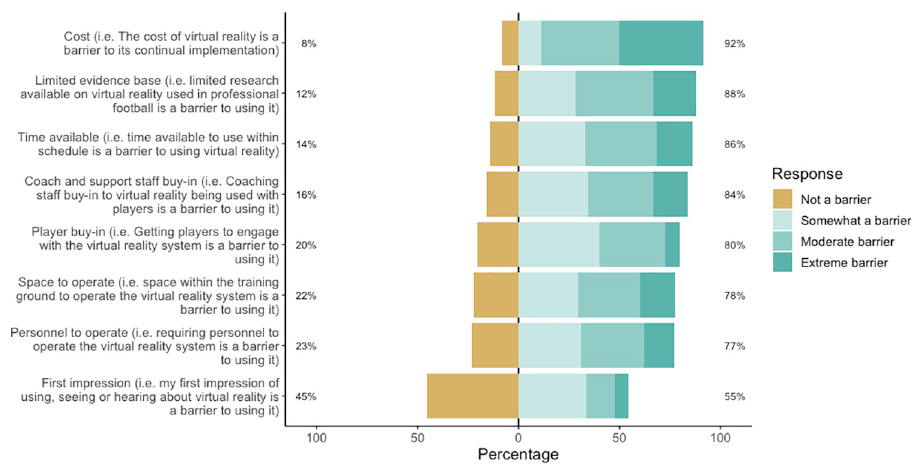
Fig 4. Responses by practitioners to statements regarding facilitating conditions to using VR. Percentages indicate not a barrier and overall barrier, from left to right respectively. For the statement ‘cost’, only 36 respondents responded as being aware of the monetary cost associated with VR.